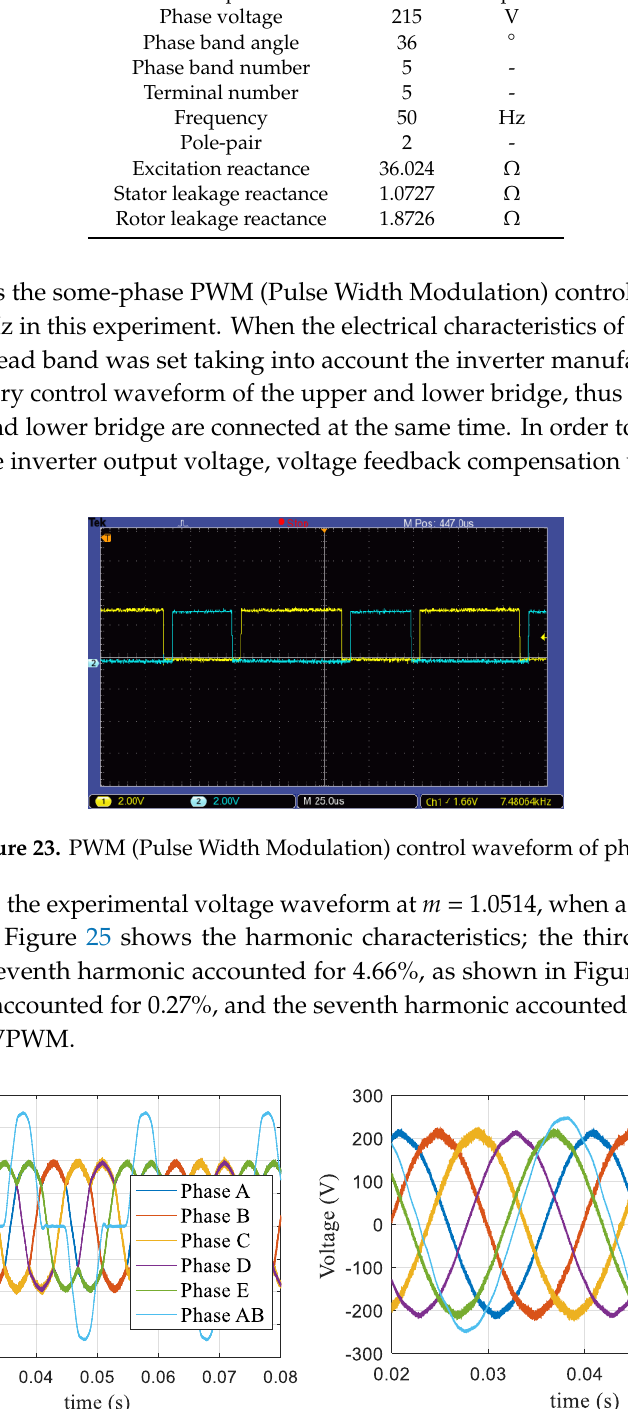
( b ) NFSVPWM Figure 25. Harmonic characteristics at m = 1.0514. Figure 26 shows the experimental voltage waveform at m = 1.0514 when the dynamic modulation algorithm proposed in this paper was used. Figure 27 shows the harmonic characteristics, wherein the third harmonic accounted for 0.22%, and the seventh harmonic accounted for 0.25%.